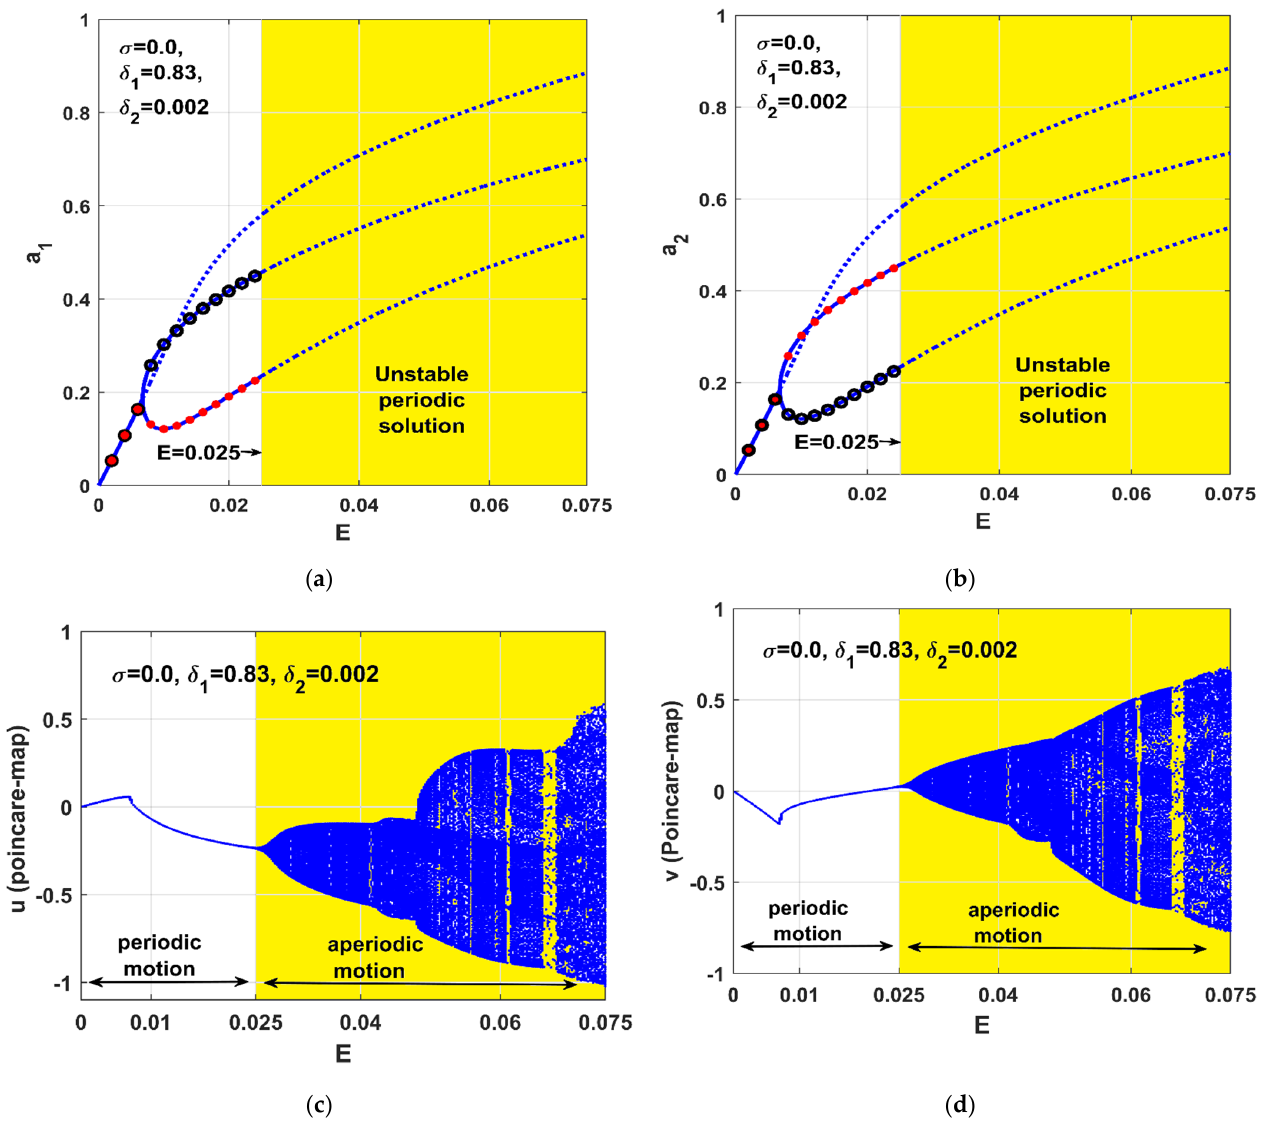
Figure 7. 𝐸 − response curve of the controlled Jeffcott rotor (i.e., 𝛿 (cid:2869) = 0.83 and 𝛿 (cid:2870) = 0.002 ) and the Figure 7. E —response curve of the controlled Jeffcott rotor (i.e., δ 1 = 0.83 and δ 2 = 0.002) and the corresponding bifurcation diagrams at 𝜎 = 0.0 : ( a , b ) oscillation amplitudes ( 𝑎 (cid:2869) and 𝑎 (cid:2870) ) versus 𝐸 corresponding bifurcation diagrams at σ = 0.0: ( a , b ) oscillation amplitudes ( a 1 and a 2 ) versus E when when 𝜎 = 0 , and ( c , d ) Poincaré-map of the instantaneous oscillations 𝑢(𝑡) and 𝑣(𝑡) versus 𝐸 σ = 0, and ( c , d ) Poincar é -map of the instantaneous oscillations u ( t ) and v ( t ) versus E when σ = 0. when 𝜎 = 0 .